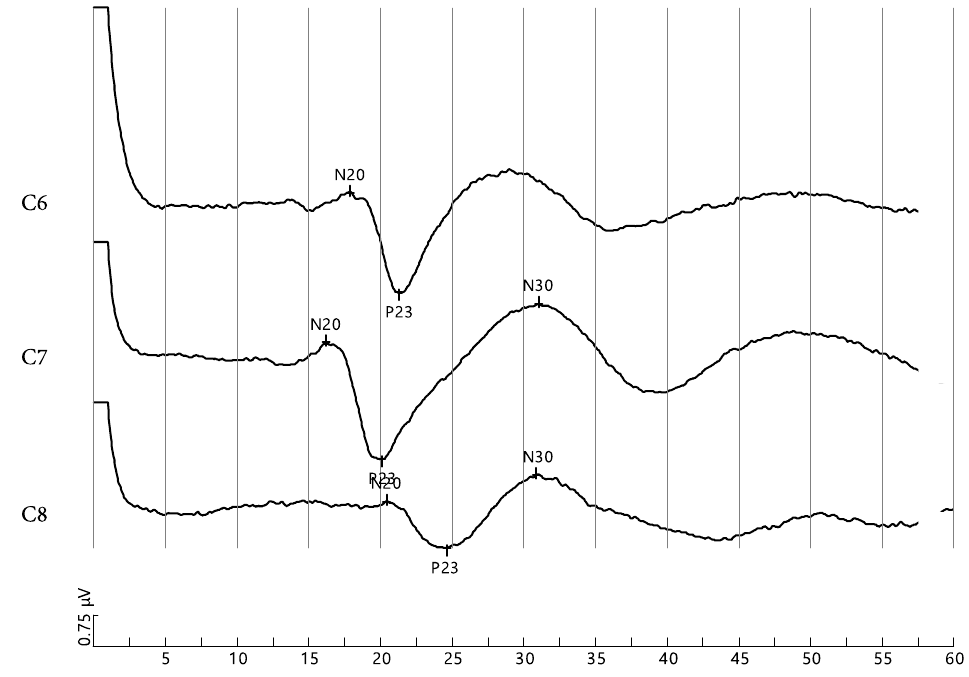
Figure 5. Short latency somatosensory-evoked potential of a normal head posture (NHP) participant before prolonged slouched sitting for C6, C7 and C8. The amplitudes measured between N20 and P23 are: 2.45 μV, 2.8 μV, and 1.14 μV, respectively.